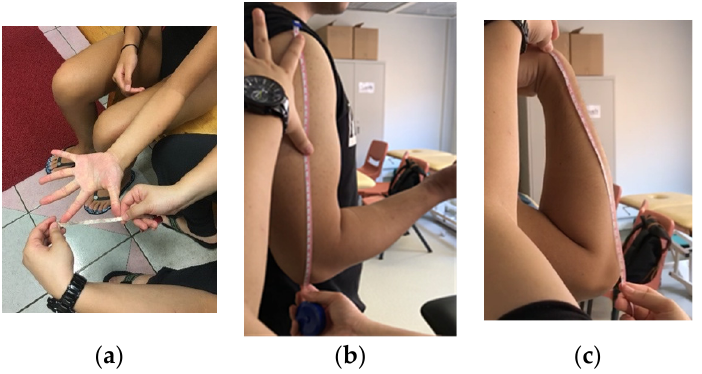
Figure 3. Methods of measurement for: ( a ) First web space; ( b ) upper arm length; ( c ) forearm